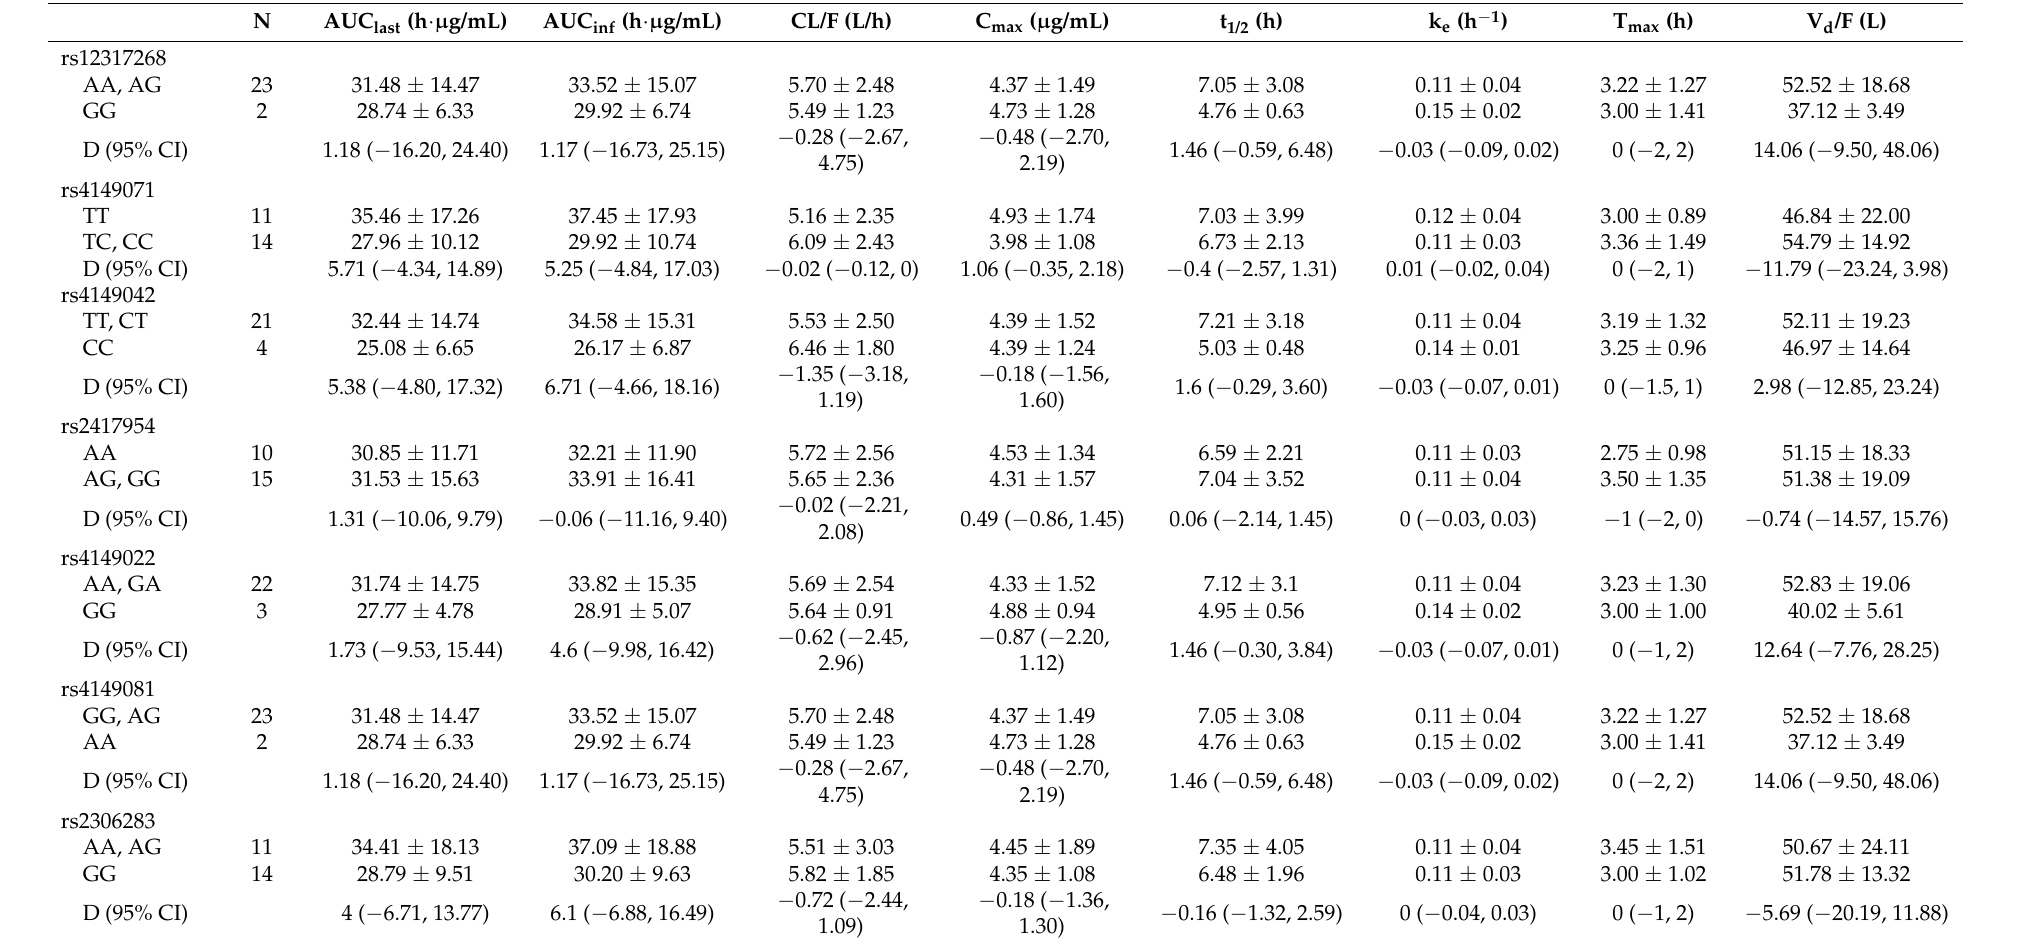
Table 2. Effects of SLCO1B1 polymorphisms on valsartan